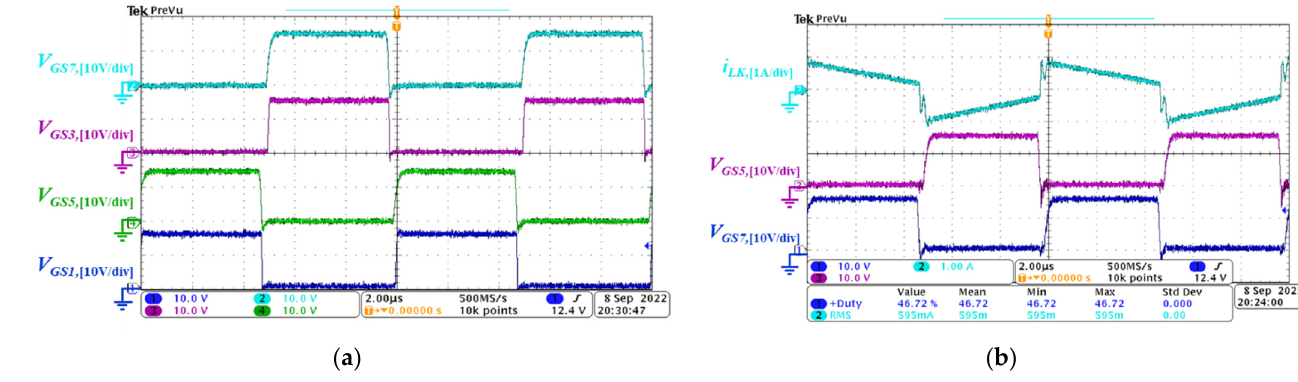
Figure 18. Experimental waveforms of the prototype converter operating in backward power con- version mode (at 200 W output power): ( a ) waveforms of gate signals V GS1 , V GS3 , V GS5 and V GS7 ; ( b ) waveforms of gate signals V GS5 , V GS7 and inductor current i LK .